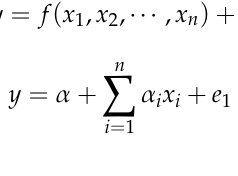
Figure 6. J-Groove shape install on the draft tube inner wall and design parameters.